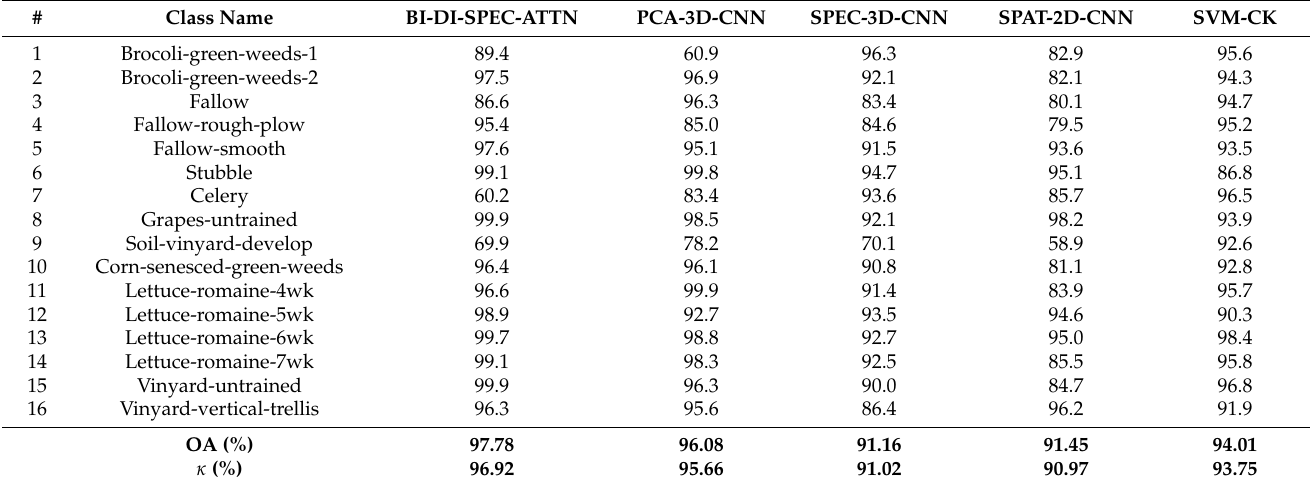
Table 6. Class-specific accuracies of Salinas dataset with 10% of training data for the proposed methodology and other models used for